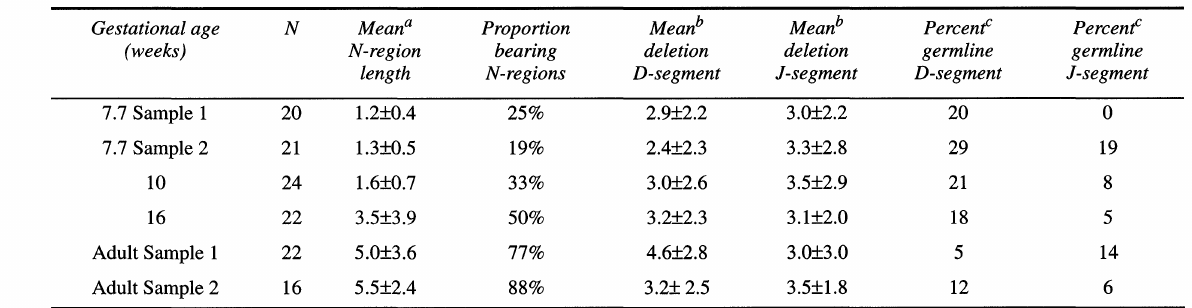
TABLE Characteristics of Fetal TCRB DJ Genomic